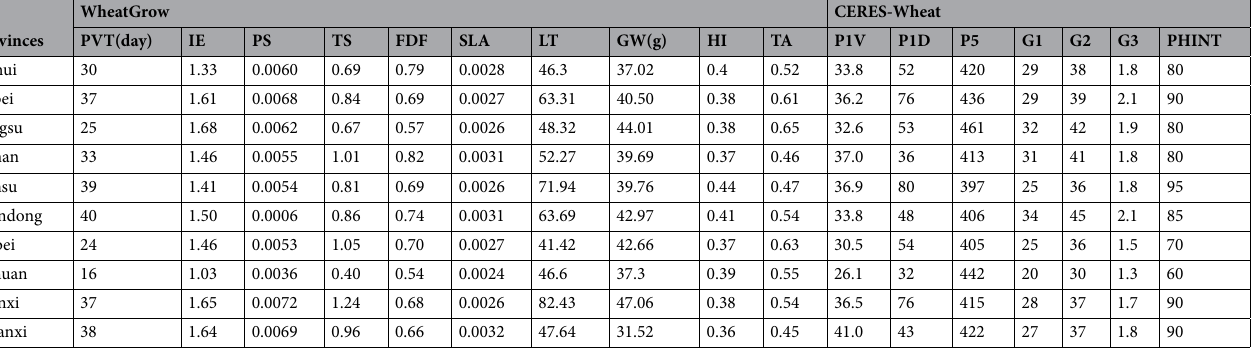
Table 1. Regional cultivar parameter values used for the WheatGrow and the CERES-Wheat models. PVT: Physiological vernalization time (d). IE: Intrinsic earliness. TS: Temperature sensitivity. PS: Photoperiod sensitivity. FDF: Filling duration factor. SLA: Specific leaf area under optimum conditions (ha kg -1 ). LT: The thermal time between two successive leaf tip appearances (°C∙d). HI: Harvest index. GW: 1000-grain weight (g). TA: Tilling ability P1V: Days required to complete vernalization. P1D: Percentage reduction in development rate in a photoperiod. P5: Grain filling phase duration (°C∙d). G1: Kernel number per unit canopy weight at anthesis (g). G2: Standard kernel size under optimum conditions (mg). G3: Standard non-stressed dry weight